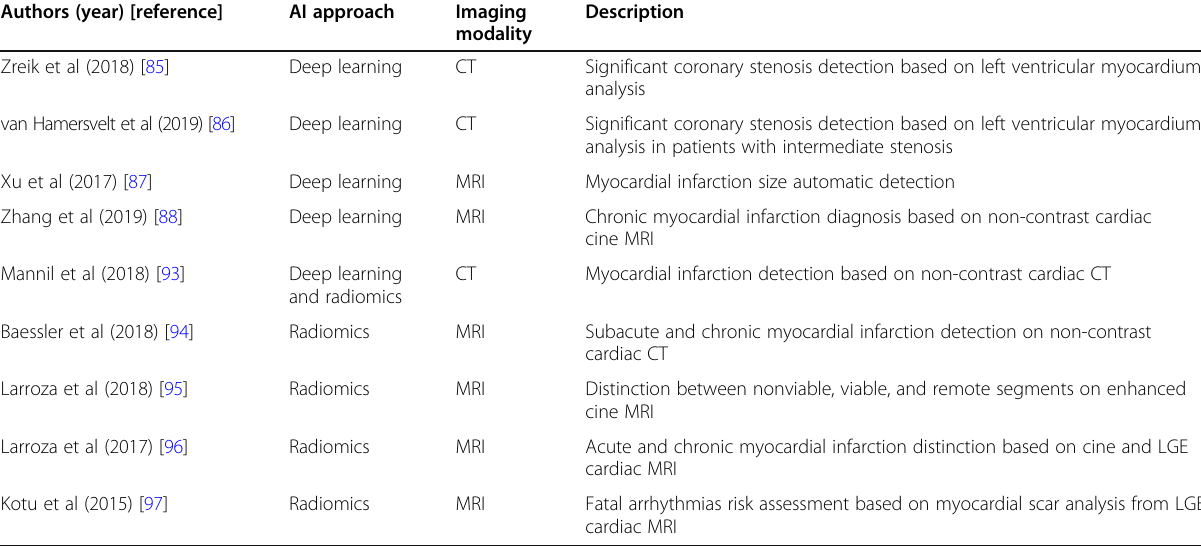
Table 1 Artificial intelligence applications in ischemic heart disease Authors (year)